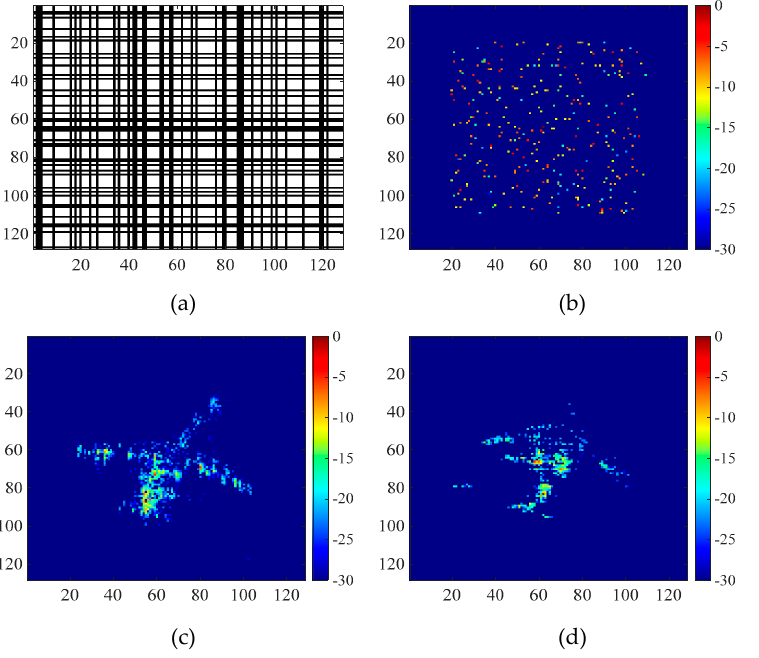
Figure 3. Data set illustration. ( a ) Data missing pattern of the 2D incomplete data. ( b ) Label image of a test sample. ( c ) RD image of the measured data with complete data and high SNR. ( d ) RD image of another measured dataset with complete data and high SNR.